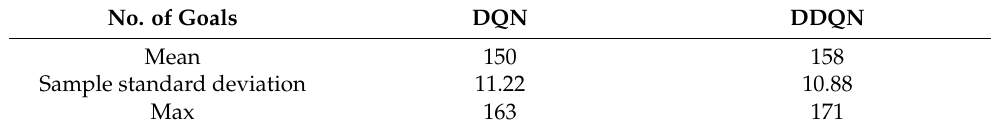
Table 3. DQN and DDQN agents’